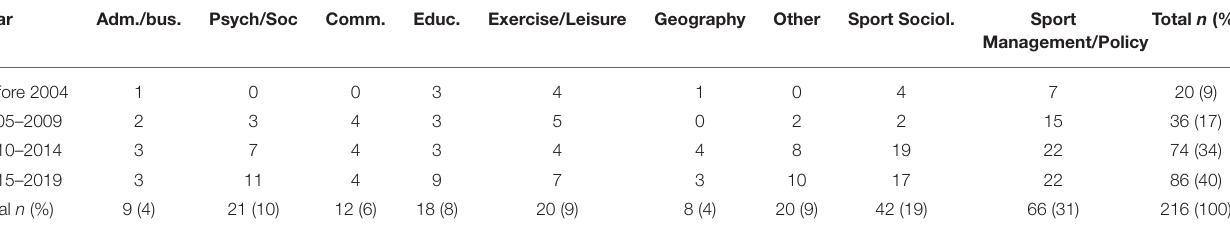
TABLE 2 | Number of annual critical social science publications in sport management by research domain and publication period (percentages between brackets). Year Adm./bus. Psych/Soc Comm. Educ. Exercise/Leisure Geography Other Sport Sociol. Sport